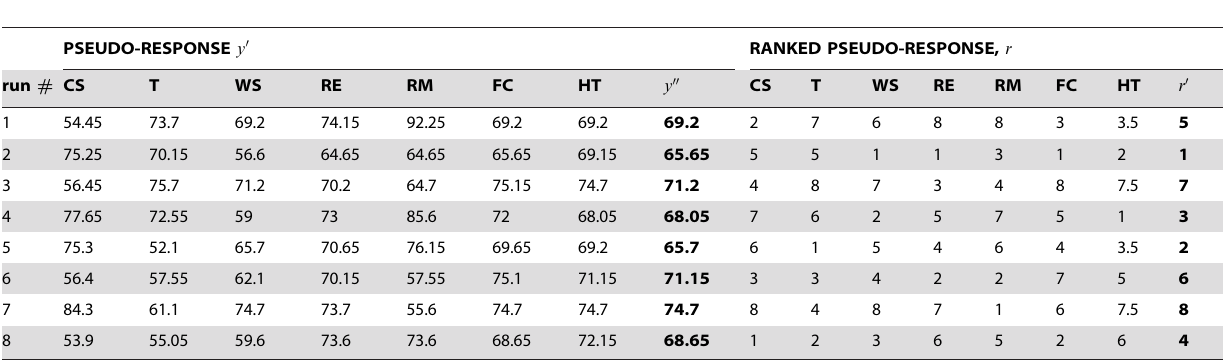
Table 4. Reconfigured data from Table 2 in terms of pseudo-responses ( y 0 ), the residual response ( y 00 ), and their associated rank values ( r , r 0 ).